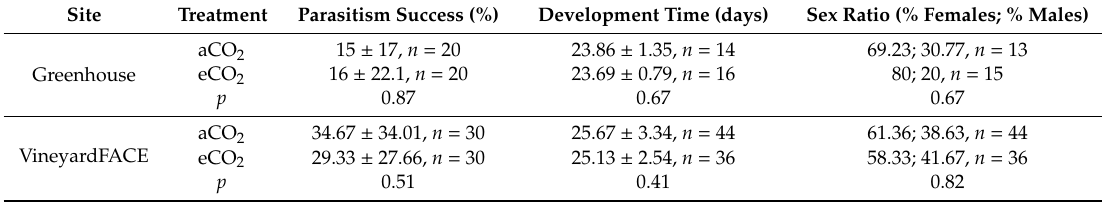
Table 1. Results from the parasitism experiment with L. dactylopii and P. ficus in a greenhouse and field (VineyardFACE) under ambient (aCO 2 ) and elevated (eCO 2 ) conditions. Values are expressed as means ±